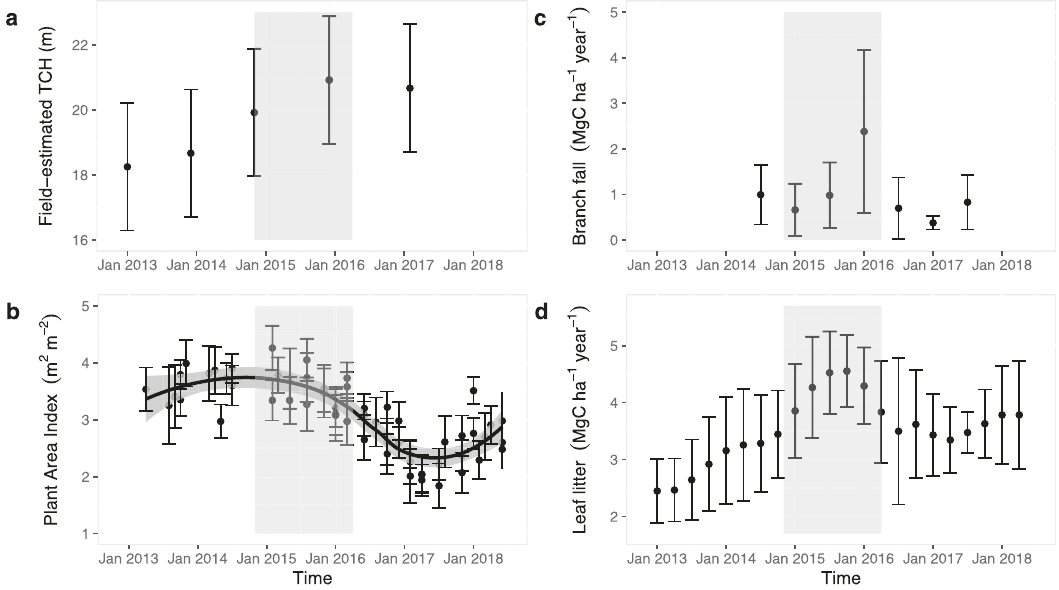
Fig. 2 The 2015 – 2016 ENSO effects on canopy properties measured in the fi eld. Time series of a top-of-canopy height (TCH), b plant area index, c branch fall and d mean leaf fall measured in forest inventory plots between 2013 and 2018. The period between LiDAR surveys, shown in grey, coincided with the ENSO event. Means with 95% con fi dence intervals are (95% CI: − 0.08 to 0.68 m per year) in 2015 but it fell to -0.06 m per year (95% CI: − 0.50 to 0.37 m per year) in 2016 (Fig. 2a), ( t = − 1.24; P value = 0.21).